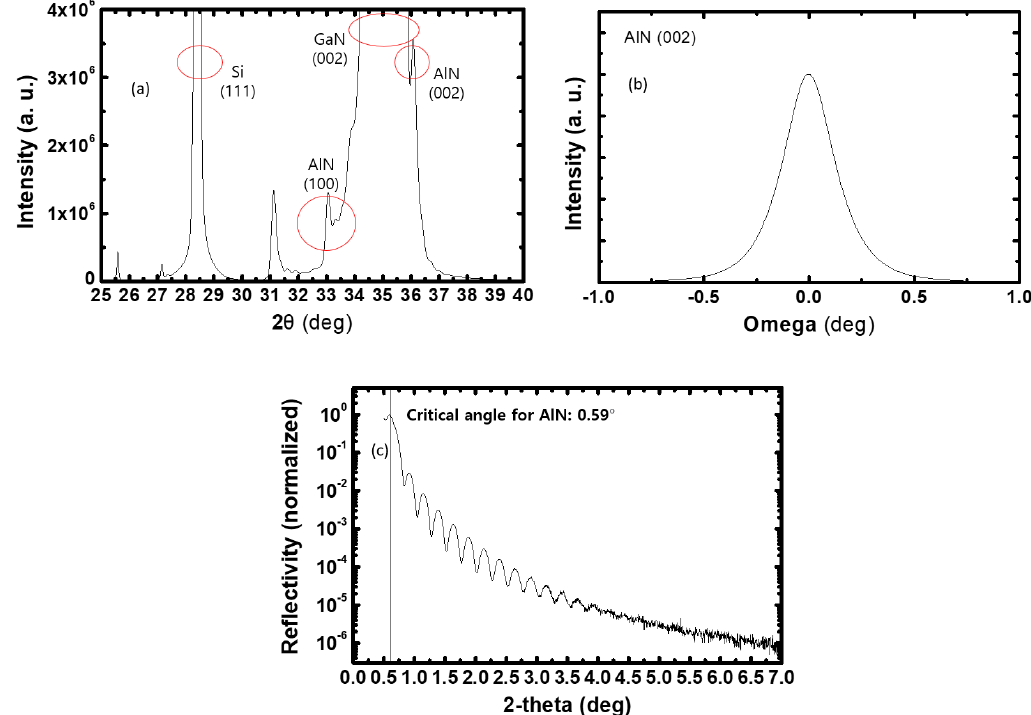
Figure 7. ( a ) XRD result and ( b ) rocking curve of (002) of the ALD AlN of ~100 nm on n-GaN and ( c ) XRR result of the ALD AlN of ~30 nm on n-GaN (NH 3 plasma power: 30 W).